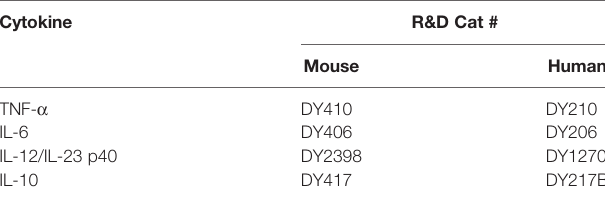
TABLE 4 | ELISA kits used for cytokine quanti fi cation in cell supernatants.